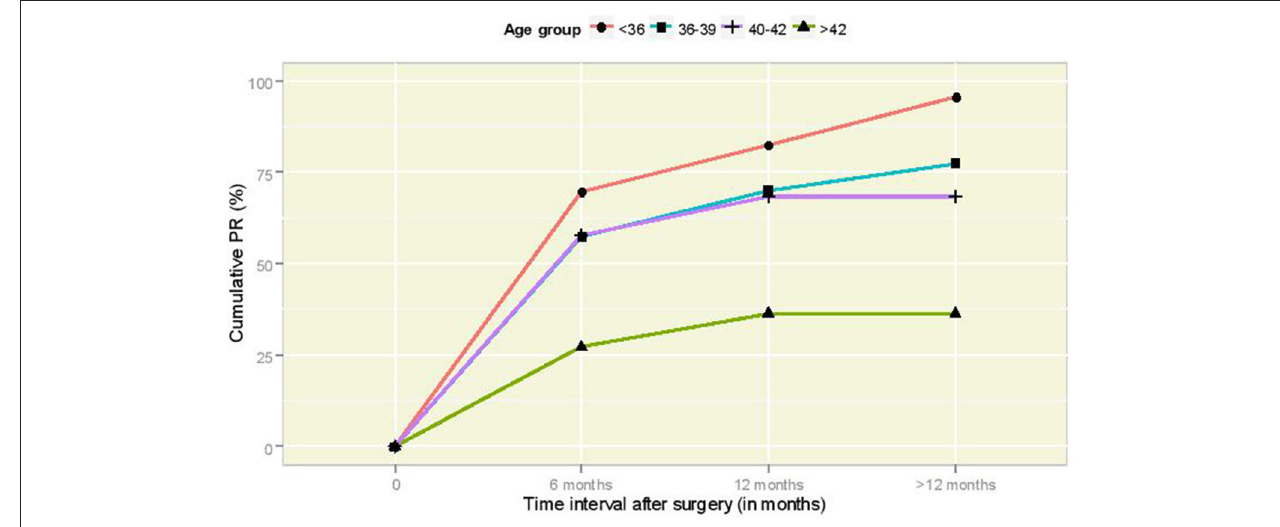
FIGURE 2 | Cumulative PR curves according to time interval (in months) after laparoscopic anastomosis for the different age groups.